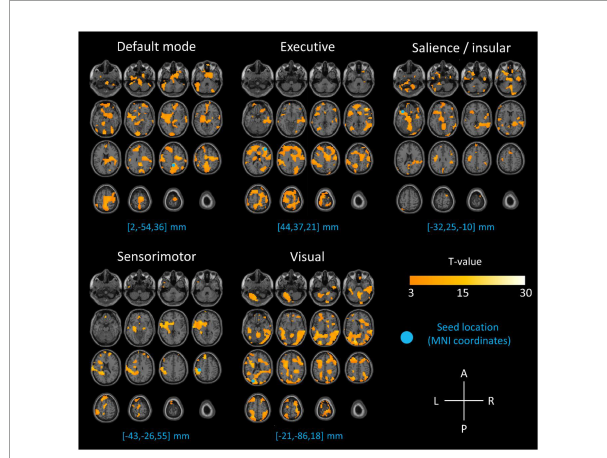
FIGURE1 Results of SPECT seed correlation analyses projected on MRI axial slices for the respective seeds of default mode (seed 2, –54, 36 mm), executive (seed 44, 37, 21 mm), salience (seed –32, 25, –10 mm), sensory-motor (seed –43, –26, 55 mm) and visual (seed –21, –86, 18 mm) networks (p-voxel < 0.001, uncorrected, corrected for the cluster volume). The blue circles indicate the location of the reference seed used for each